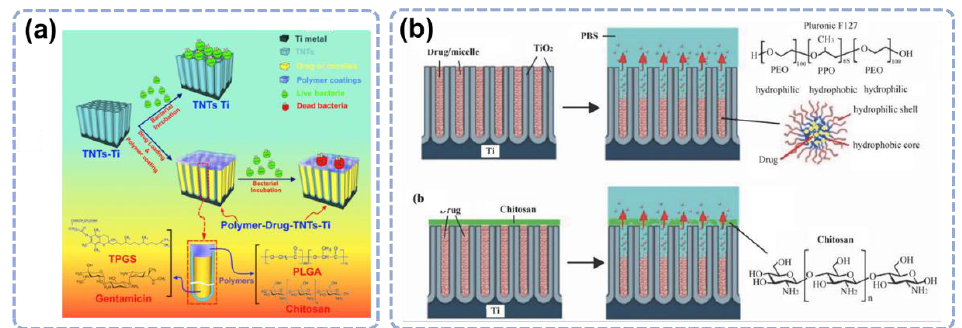
Figure 4. ( a ) Schematic illustration of the drug release control by TiO 2 nanotubes. Reprinted with permission from Ref [59]. Elsevier, 2015. ( b ) Polymeric micelles were used as nanocarriers and a chitosan polymer layer was coated on top of the nanotubes to control drug release. Reprinted with permission from Ref [60]. Scientific Research, 2011.